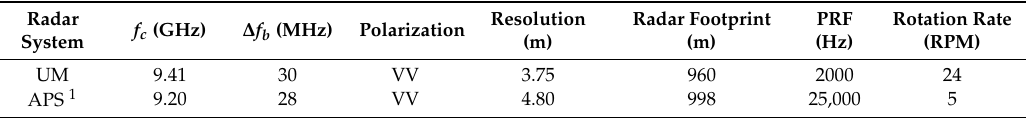
Table 1. Radar parameters: center frequency ( f c ), bandwidth ( ∆ f b ), polarization, resolution, footprint, pulse repetition frequency (PRF), and rotation rate